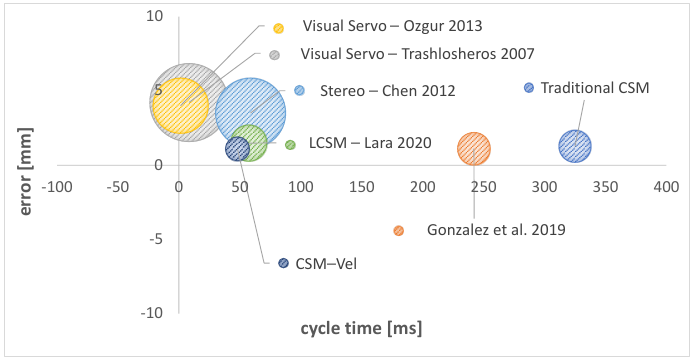
Figure 9. Static error vs. cycle time. Table 4. Cycle time and tracking error